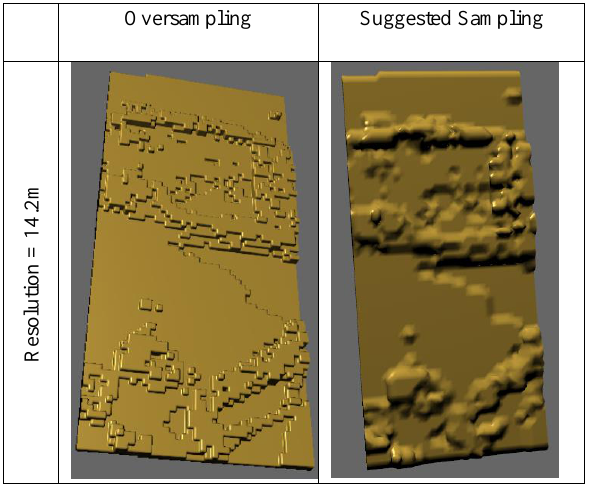
Figure 2: Oversampling versus suggested